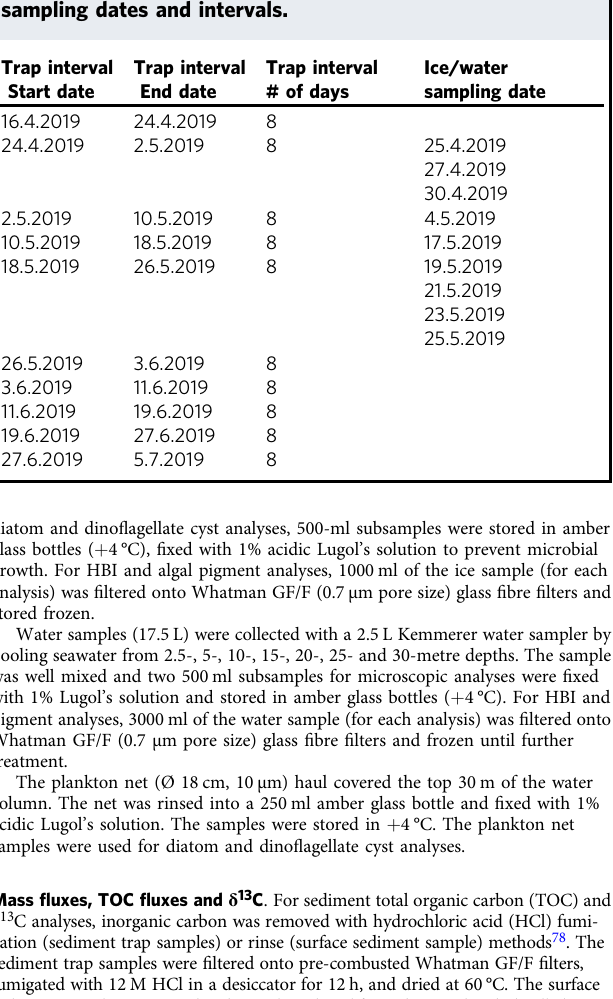
Table 1 The sediment trap, water column and ice core sampling dates and